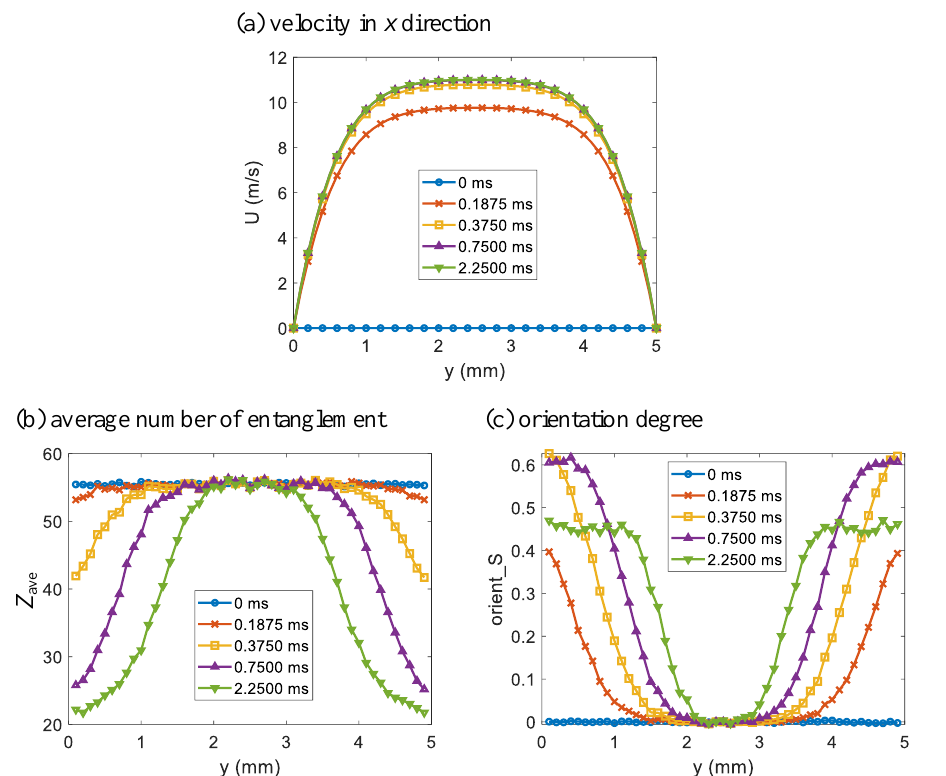
Figure 3. The multiscale simulation results of ( a ) velocity in x direction, ( b ) average number of entanglements and ( c ) orientation degree distributions in the y direction of Poiseuille flow at different times as indicated.